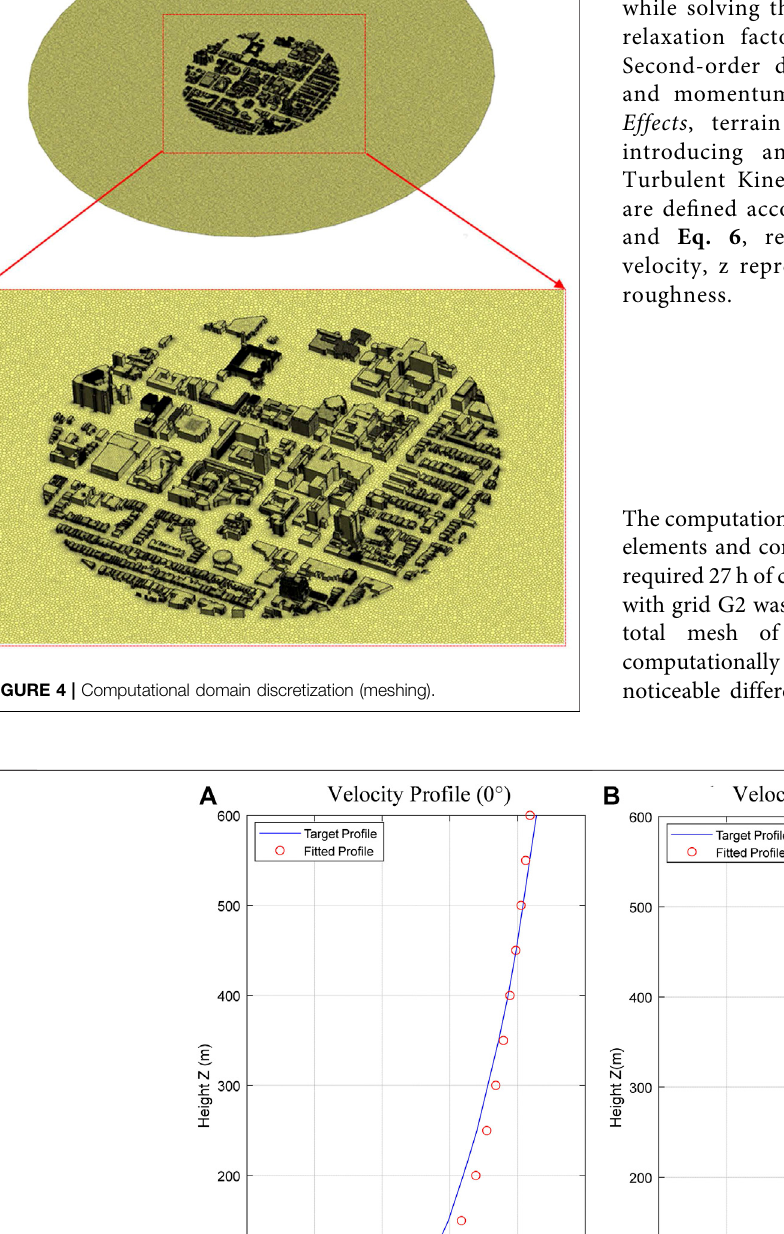
Frontiers in Built Environment |